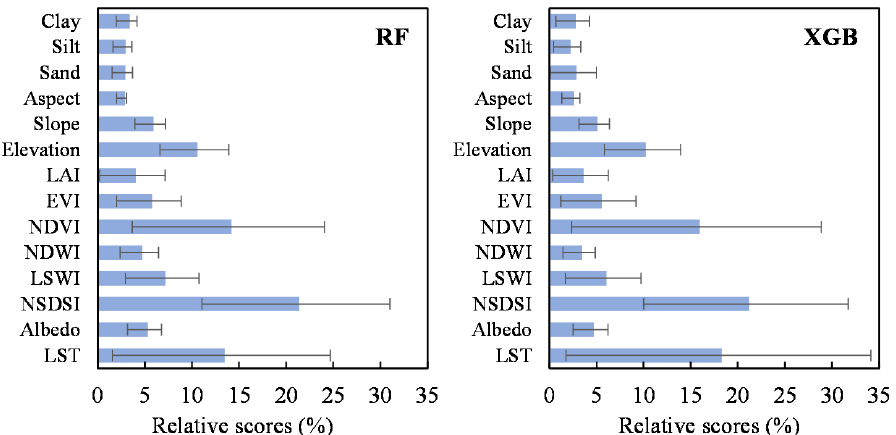
Figure 13. The average importance scores of variables for the RF-based approach and XGB-based approach. Note that the importance scores are presented by increase in node purity (IncNodePurity), where the sum value is normalized for the RF model. The XGB model uses gain to reflect the weight of